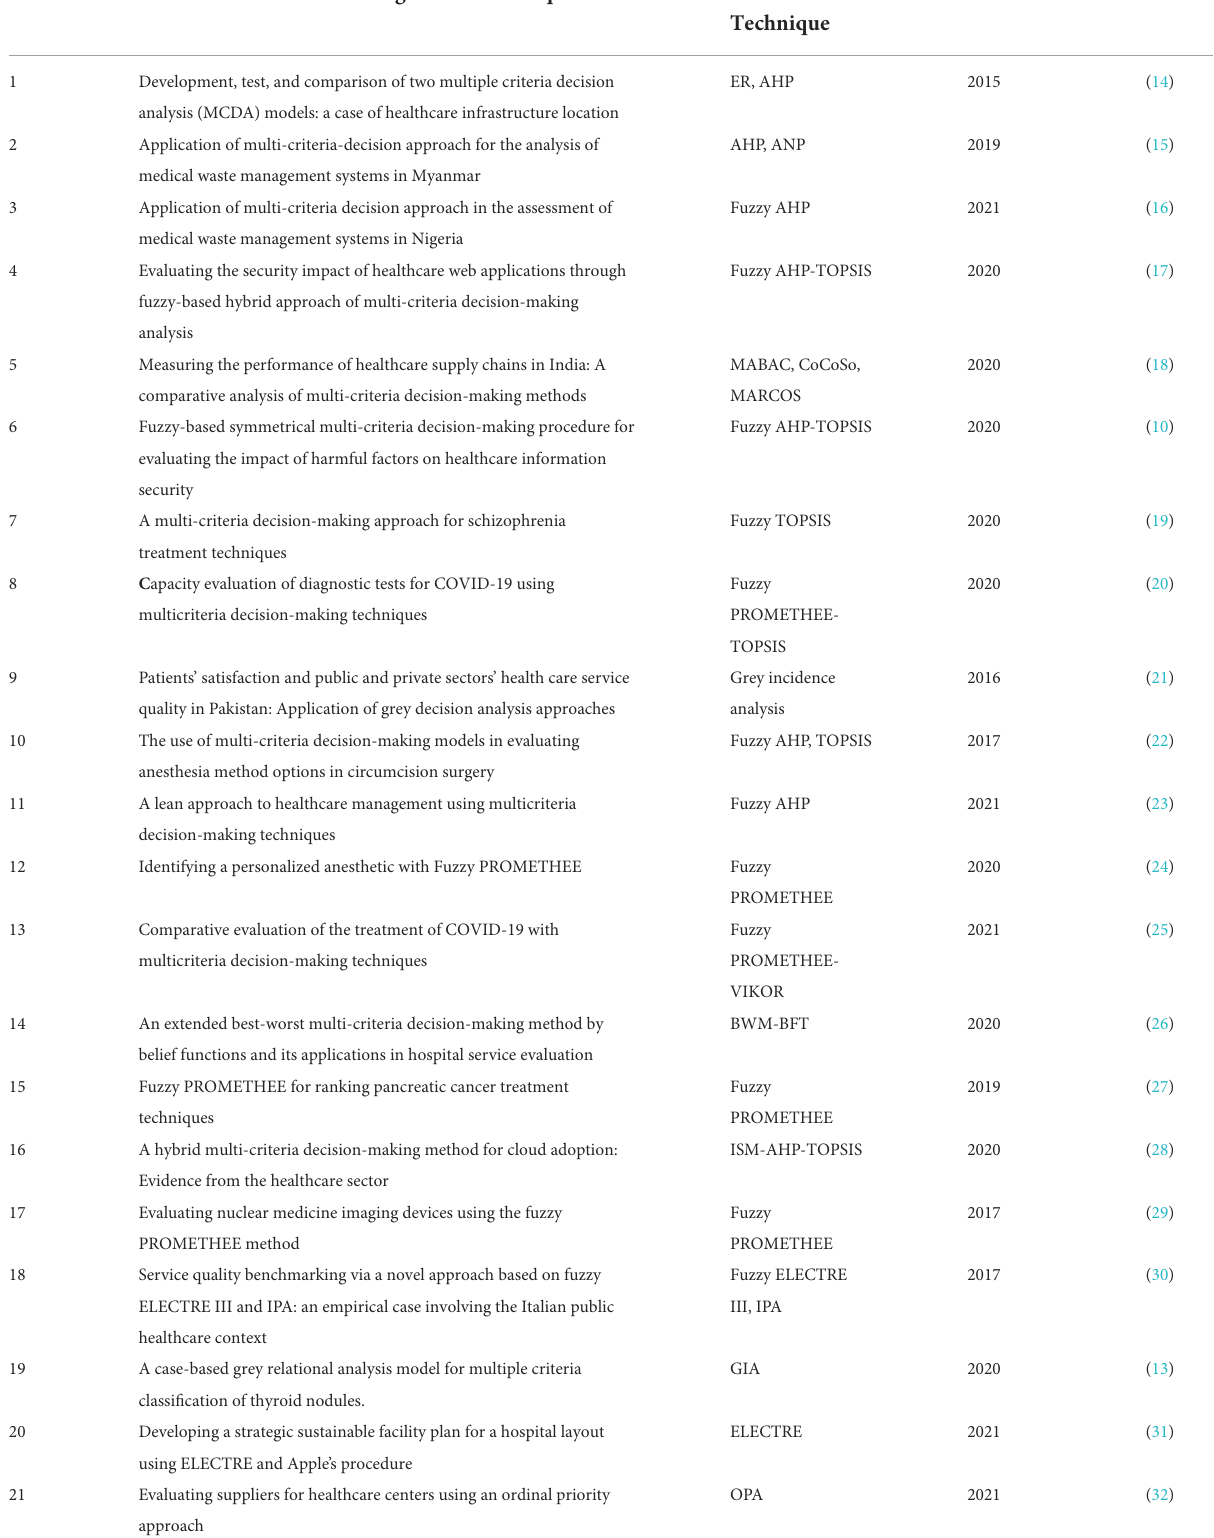
TABLE 1 Multicriteria decision analysis (MCDA) techniques in healthcare.